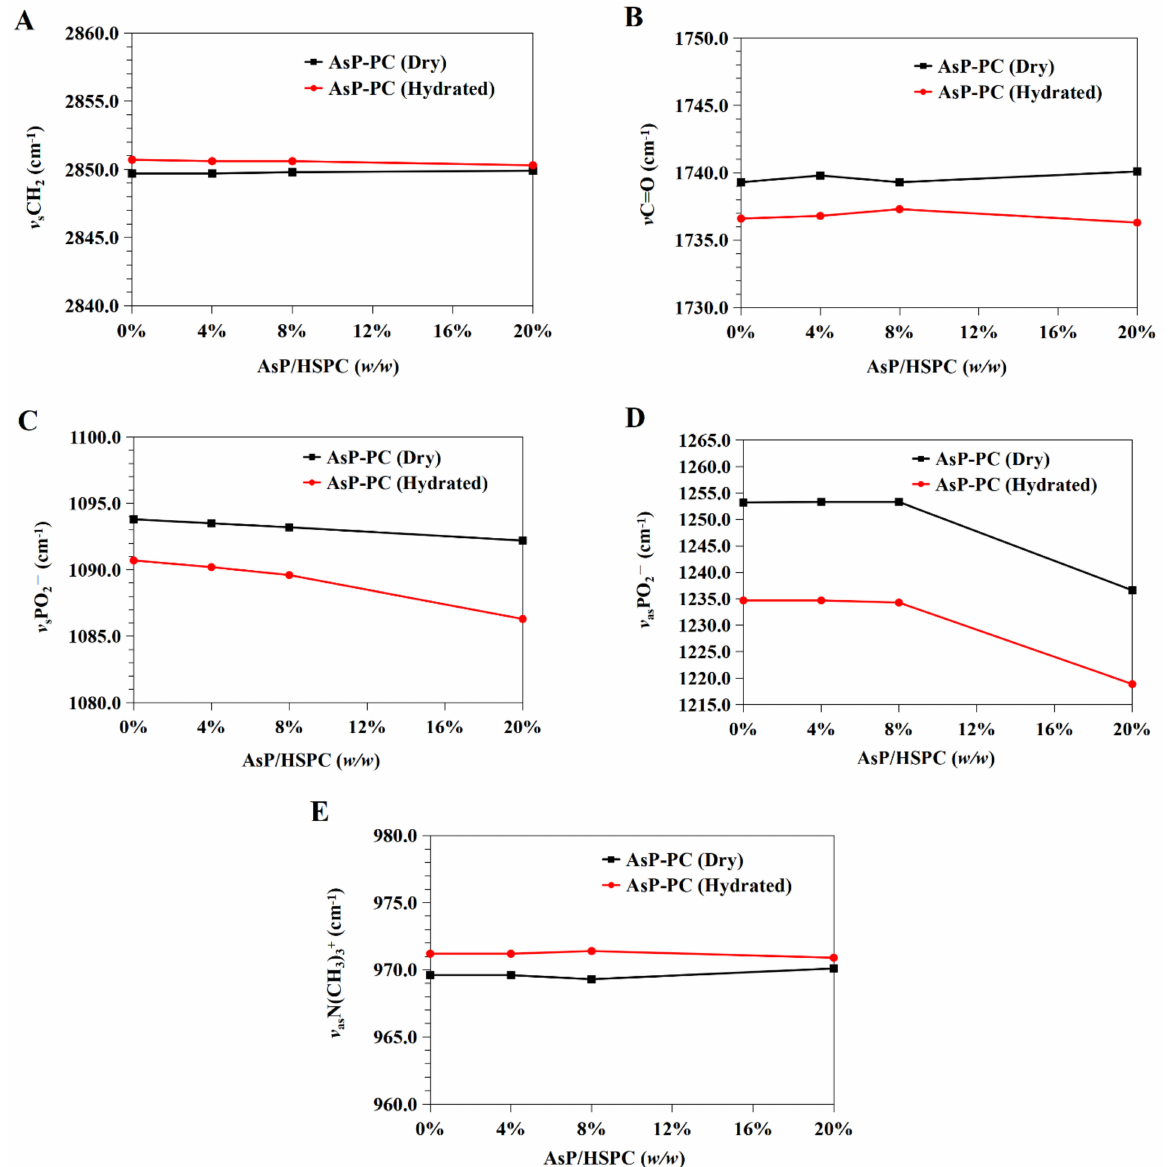
Figure 7. Infrared wavenumber displacement dependence on AsP proportion in the FTIR spectra of the dry and hydrated AsP–PC composites: ( A ) the CH 2 symmetric stretching band ( ν s CH 2 ); ( B ) the C=O stretching band ( ν C=O); ( C ) the symmetric stretching band of PO 2 − ( ν s PO 2 − ); ( D ) the antisymmetric stretching band of PO 2 − ( ν as PO 2 − ); ( E ) the antisymmetric stretching band of the choline group ( ν as N(CH 3 ) 3+